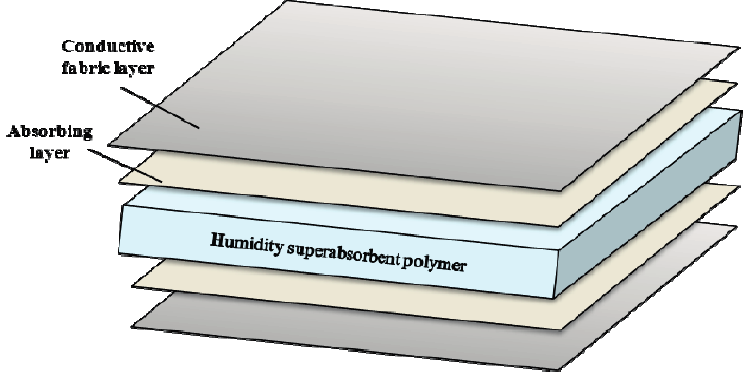
Figure 3. Fabric electrode with embedded superabsorbent